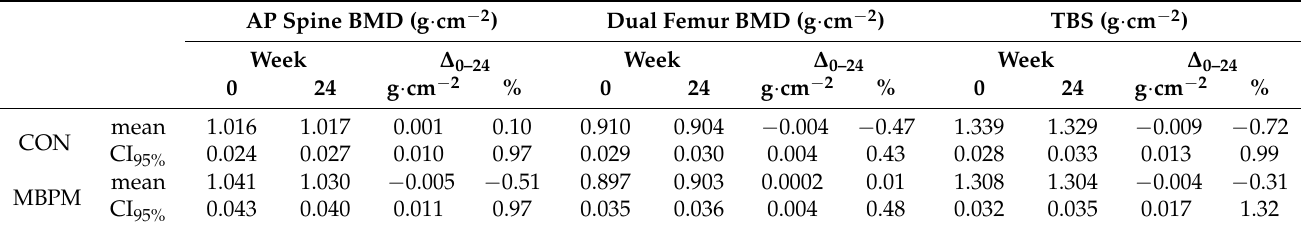
Table 3. Absolute and relative percentage change in bone mineral density (BMD) and trabecular bone score (TBS) following 24-week intervention in CON and